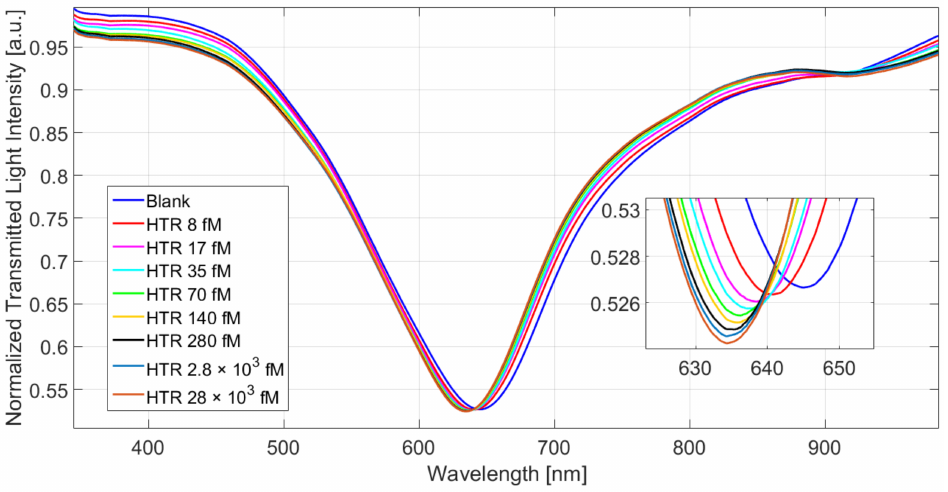
Figure 3. Normalized transmission spectra obtained for different values of HTR concentration (from 8 to 28 × 10 3 fM). Measurements were performed in